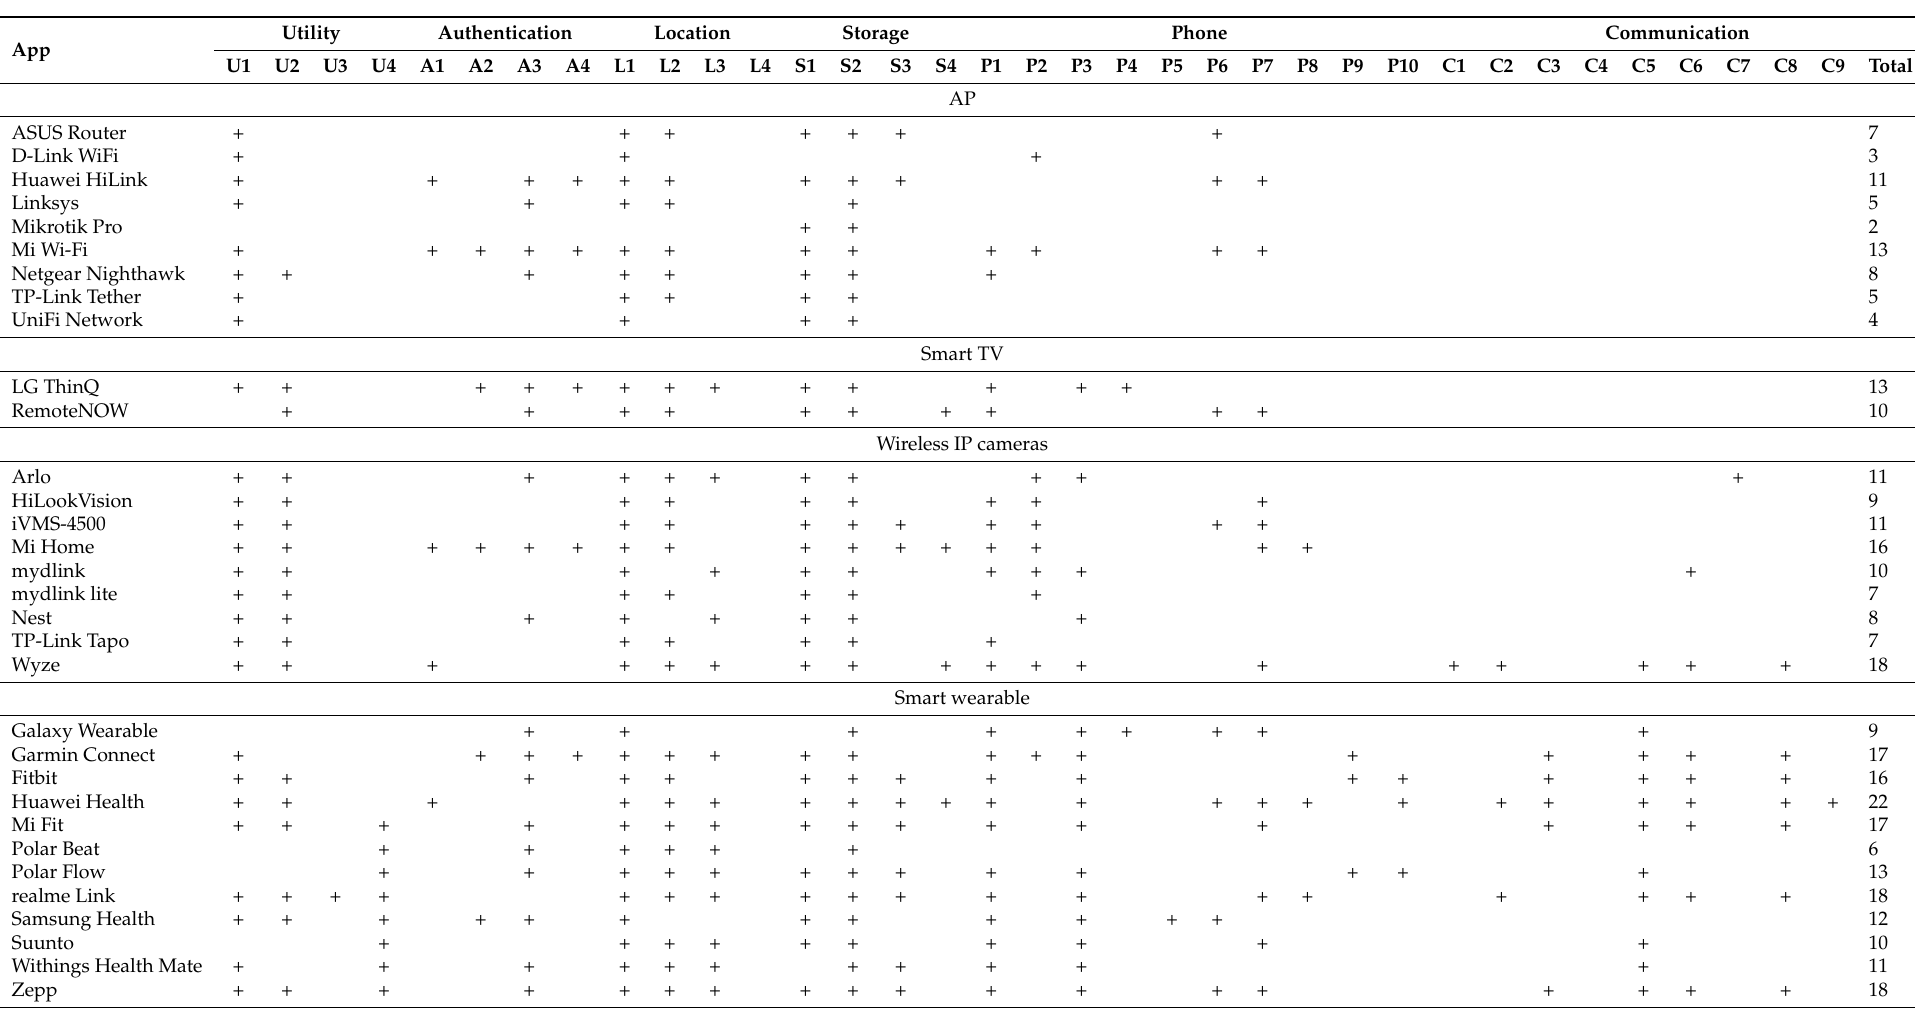
Table 2. Identified permissions per examined